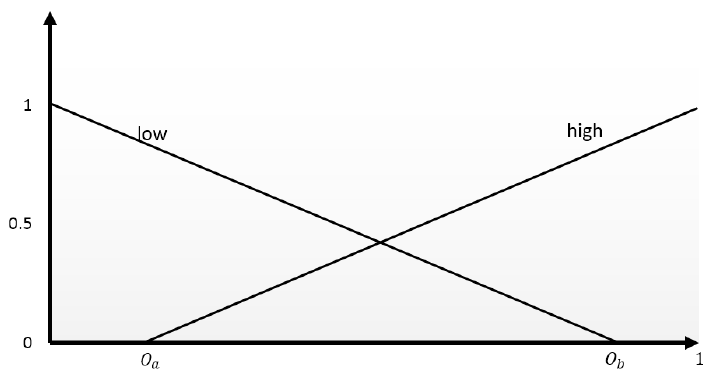
Figure 5. Two output attribution